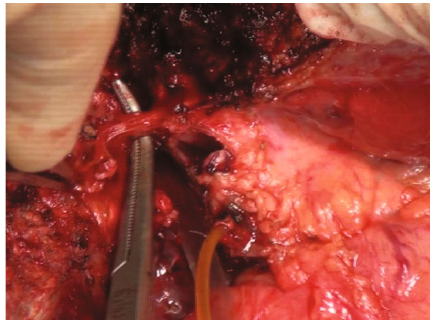
Figure 7: Exposing intrahepatic right bile duct after right portal vein, right hepatic artery ligation, and division and transecting hepatic